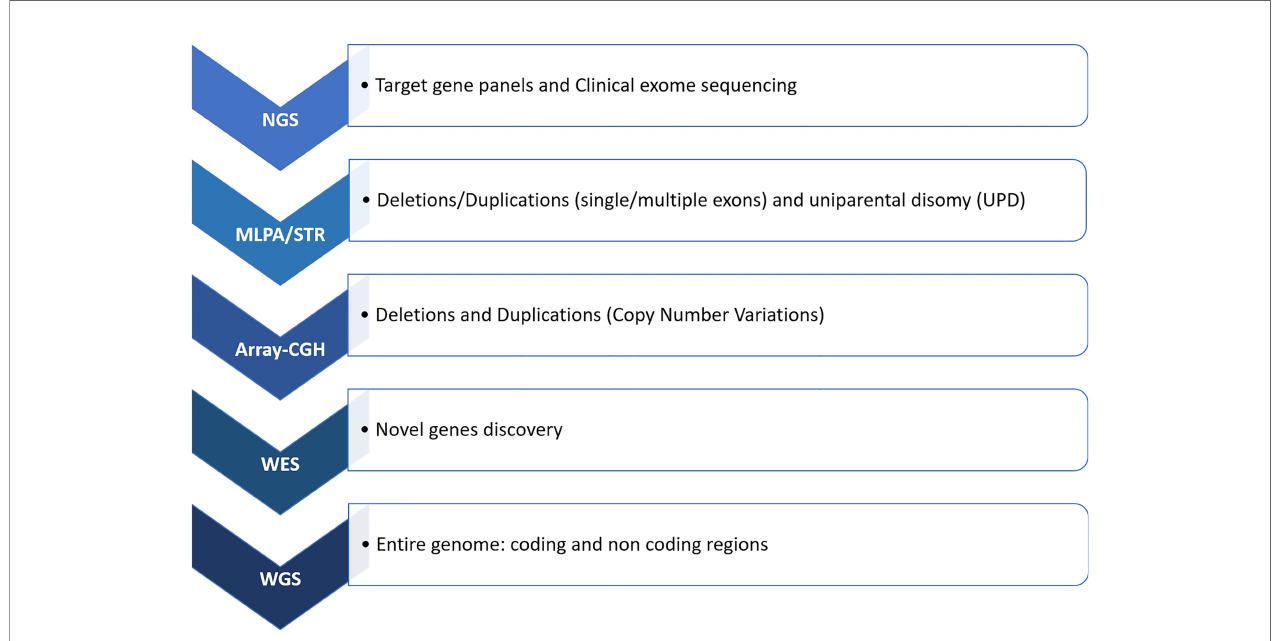
FIGURE 2 | Molecular work fl ow for hypoglycemic conditions. In cases of not conclusive results from NGS, a research for deletion/duplications should be performed through MLPA and array-CGH. Integration with STR can be worthwhile when an uniparental disomy is suspected. Subsequently, WES and WGS techniques can be used for sequencing the entire genetic code. NGS, next generation sequencing; MLPA, multiple ligation-dependent probe ampli fi cation; array-CGH, comparative genomic hybridization array; STR, short tandem repeats; WES, whole exome sequencing; WGS, whole genome